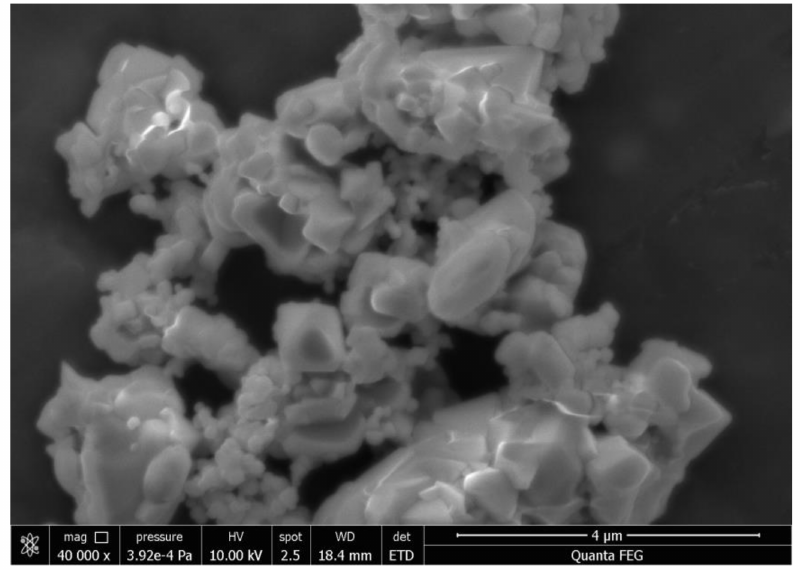
Figure 1. SEM image of BiSnSbO 6